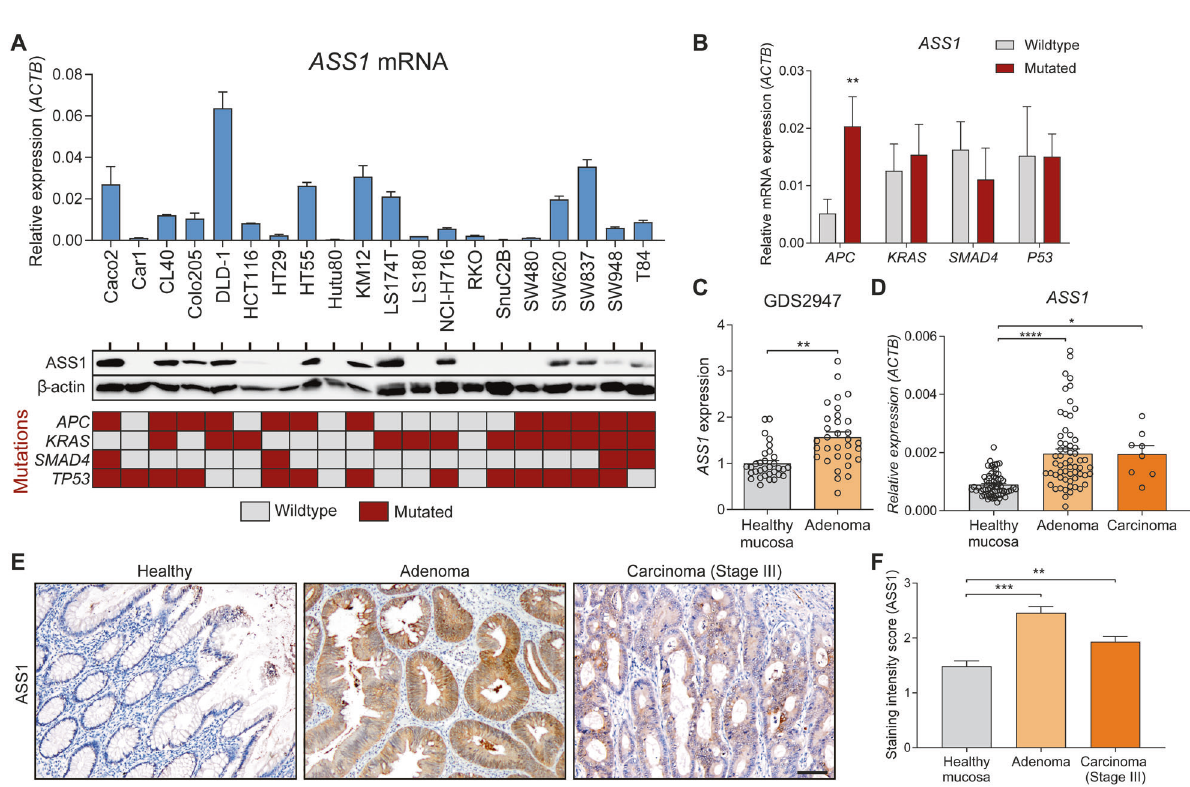
Fig. 2 ASS1 expression is upregulated and correlates with APC mutations in human colorectal adenomas and carcinomas. A ASS1 mRNA and ASS1 protein expression in 20 different colorectal cancer cell lines. Per cell line the mutational status of APC , KRAS , SMAD4 , and TP53 is indicated below. B ASS1 mRNA expression in the same 20 colorectal cancer cell lines as in ( A ), separated by their mutational status. ** p < 0.01 by Kruskal-Wallis test. C ASS1 expression in paired samples of normal mucosa and colorectal adenoma tissue ( n = 32) from the publicly available expression dataset GDS2947. **** p < 0.0001 by Wilcoxon signed rank test. D qRT-PCR for ASS1 in tissue from 60 adenoma and 8 carcinoma samples with paired controls. * p < 0.05, **** p < 0.0001 by Wilcoxon signed rank test. E immunohistochemistry for ASS1 in healthy ( n = 70), adenoma ( n = 12), and carcinoma ( n = 75) tissue. Micrographs show representative images. Scale bar indicates 100 µm. F Quanti fi cation of ( E ), which was scored in a blinded manner by two independent observers. ** p < 0.01, *** p < 0.001 by one-way ANOVA with Tukey ’ s multiple comparisons test.